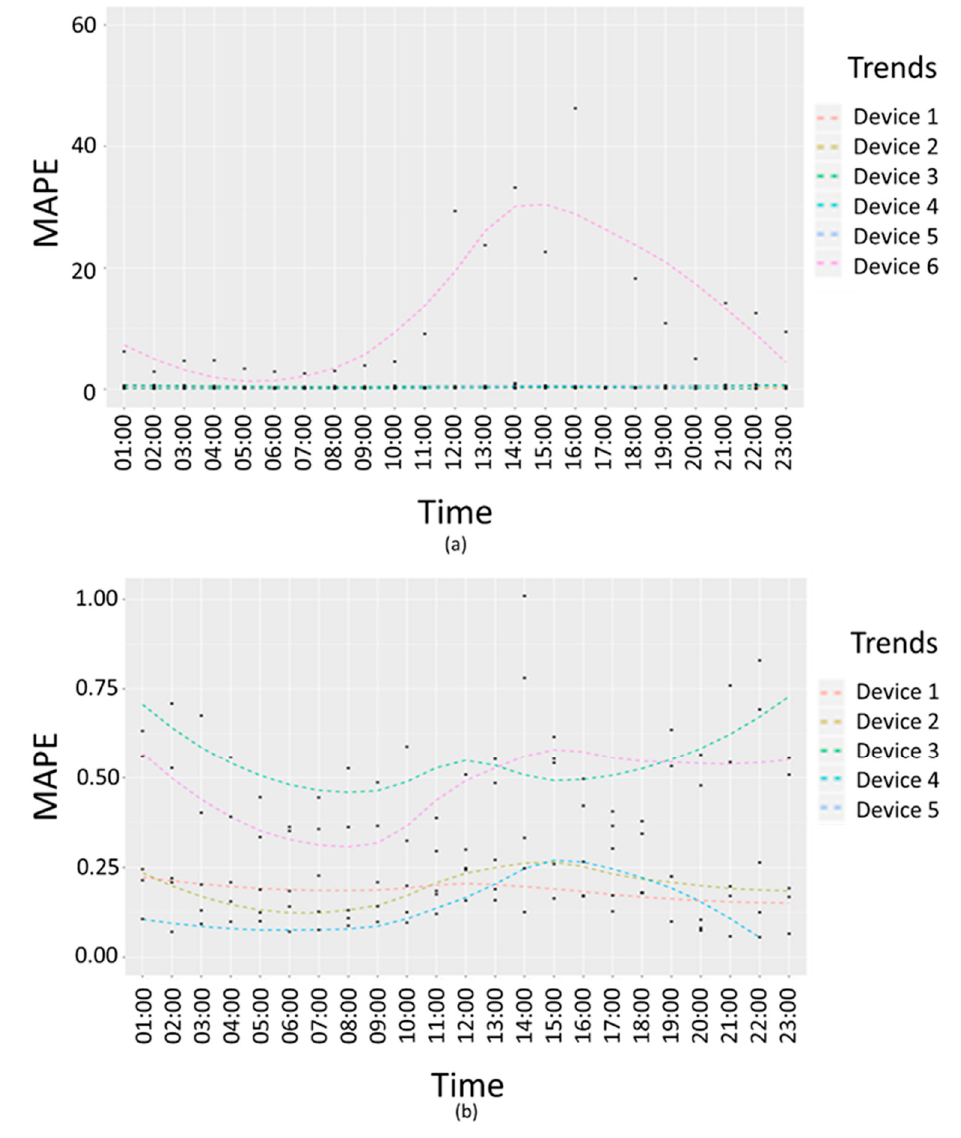
Figure 12. Air quality PM 10 working days interpolation error trends per hour in terms of mean absolute percentage error for ( a ) six personal devices including the device with a dysfunction; ( b ) five personal devices.